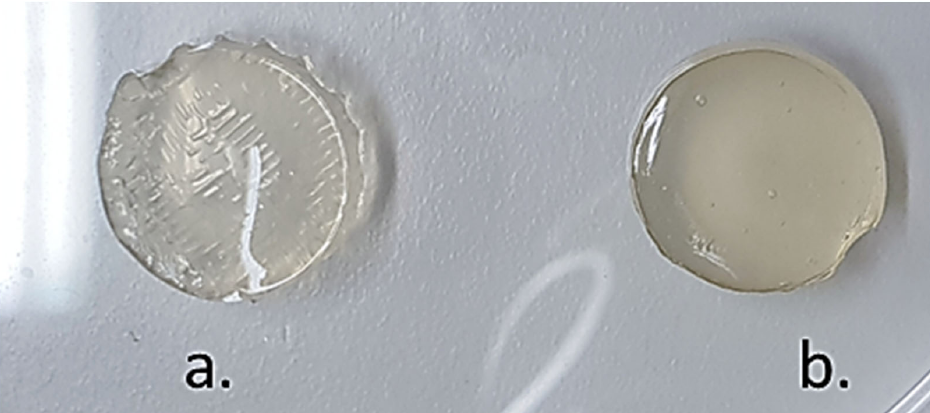
Figure 9. Images of typical 3D printed SA ‐ GL tablet ‐ shaped matrices produced using a 3D bioplotter